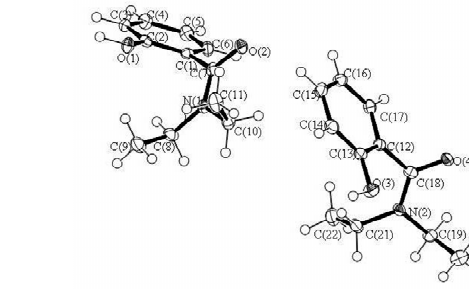
Figure 15. The 1 H and 13 C NMR spectra β -hydroxy naphthalene amide derivative as a function of temperature in (CD 3 ) 2 CO. Reprinted from Ref [68]. Copyright 2015, Elsevier.